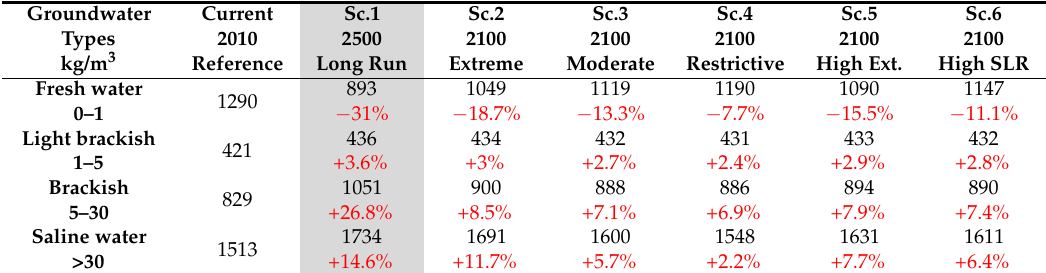
Table 2. Groundwater volume in × 10 9 m 3 in the Nile Delta aquifer (NDA) for the four groundwater